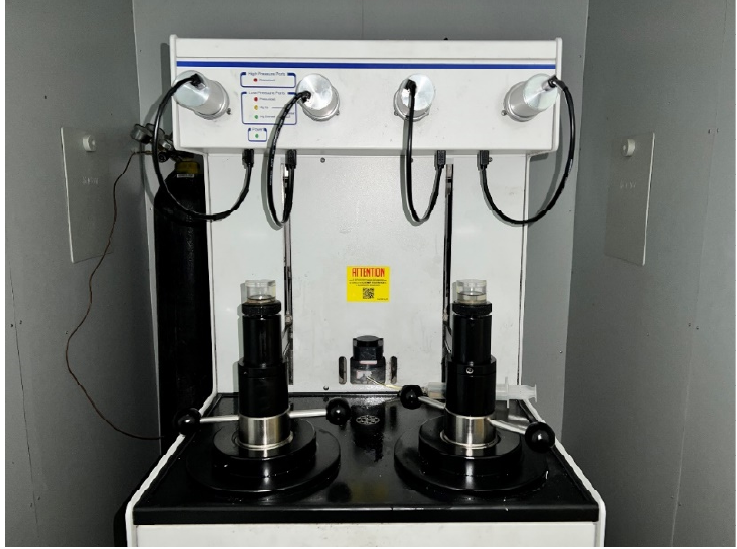
Figure 3. Mercury porosimeter.